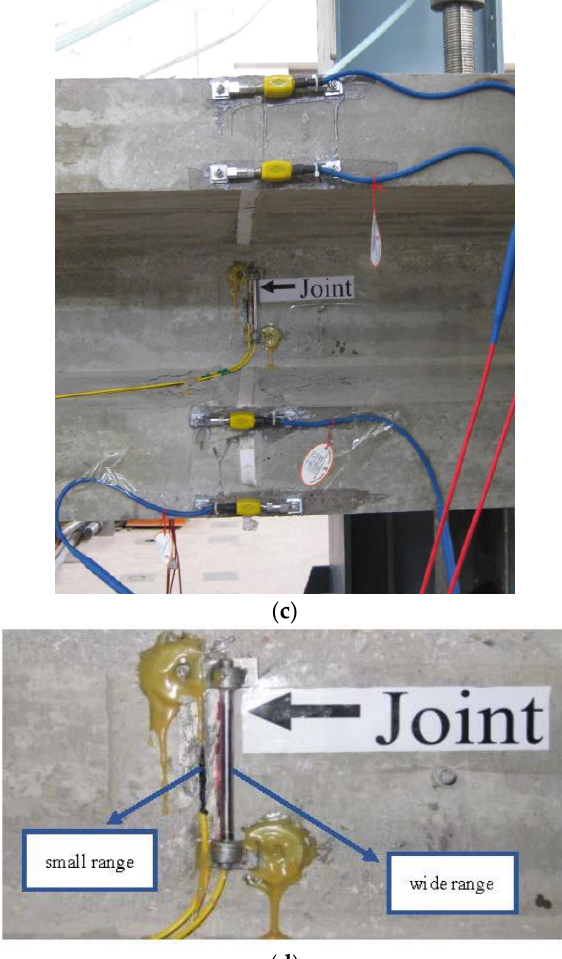
Figure 4. Loading of girders and measuring of shear deformation at the segmental joint. ( a ) Loading of girders. ( b ) Test plan. ( c ) Test pattern. ( d ) FBG details.